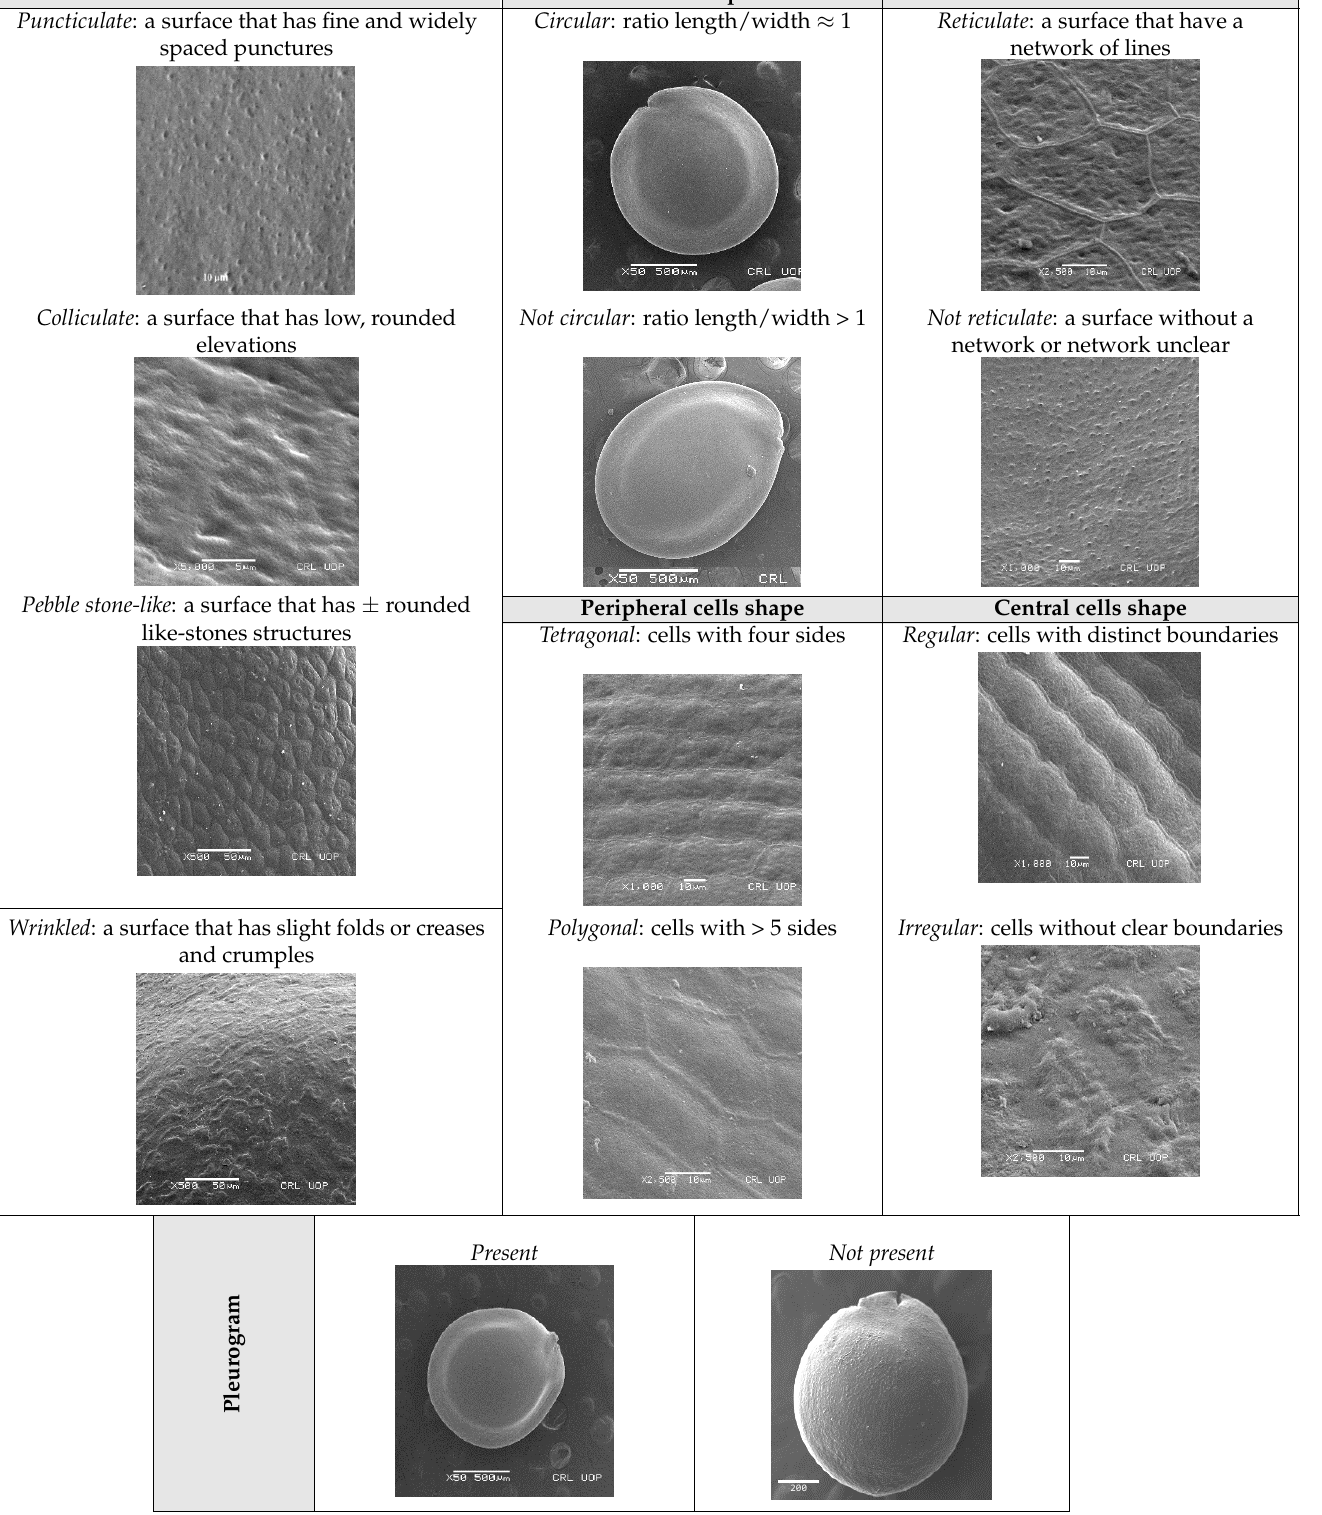
Table 3. Qualitative characters, their definition, and associated types-pictures.